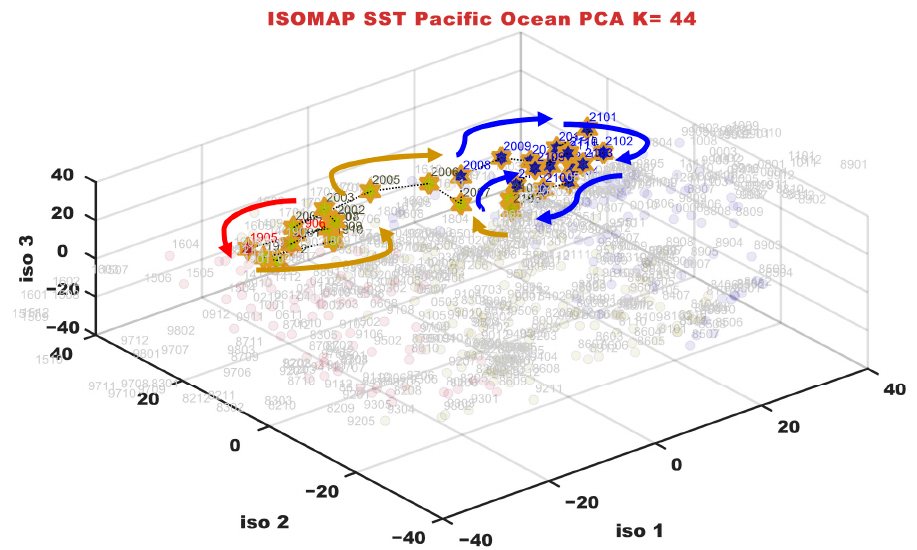
Figure 4. 3D structure composed of the three leading ISOMAP components but only has the recent 31-month data points highlighted. The curves marked by arrow s depict the time evolution (May 2019 to December 2021) of these points. The trajectory shows the end of last El Niño (red arrows), circling in normal events (yellow arrows), dramatically changing to be La Niña (blue arrows) with a bigger circle route then back to two-month normal events, and to be La Niña